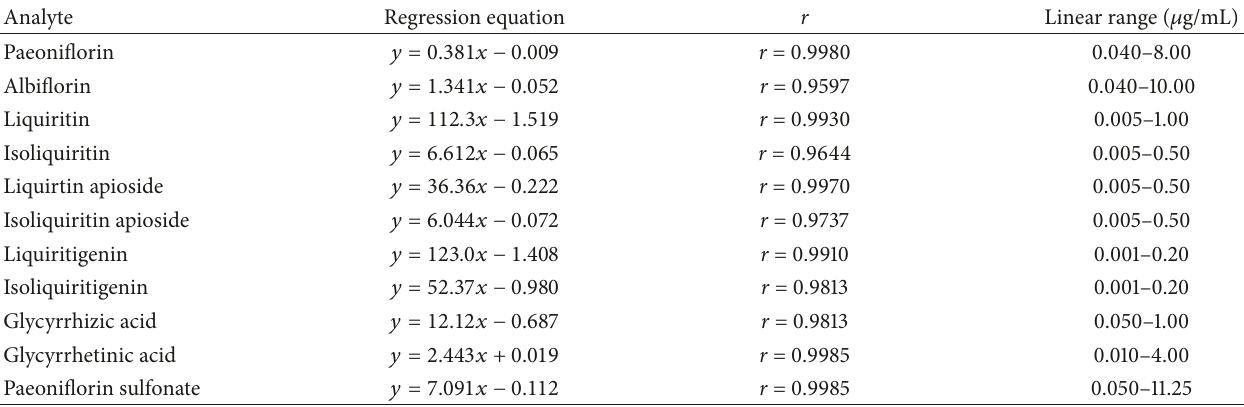
Table 2: Calibration curves and linear ranges of detected compounds ( n = 8).